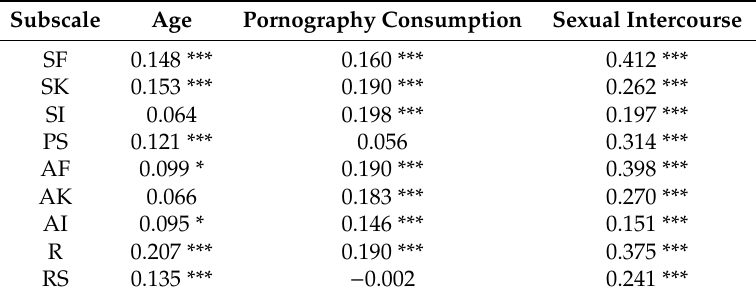
Table 4. Kendall’s Tau coe ffi